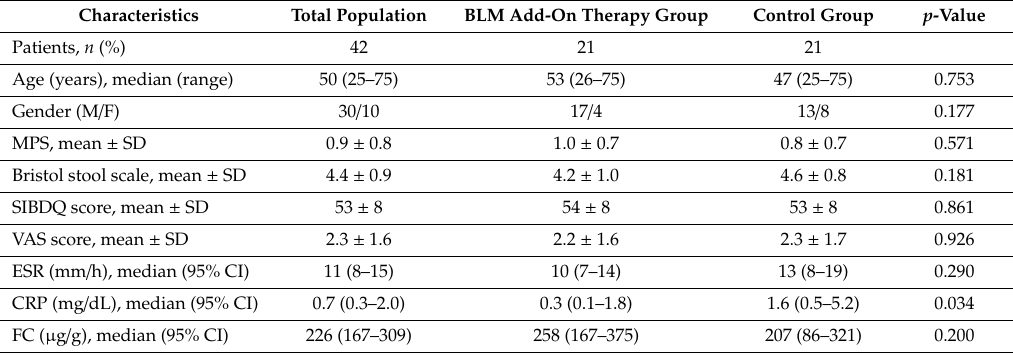
Baseline characteristics of the overall study population and according to the BLM add-on